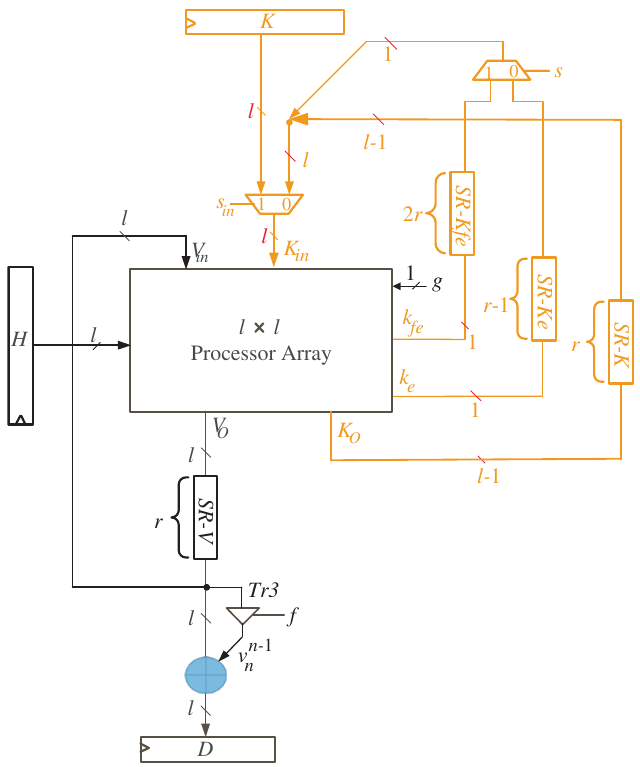
Figure 4. Multiplier SISO processor